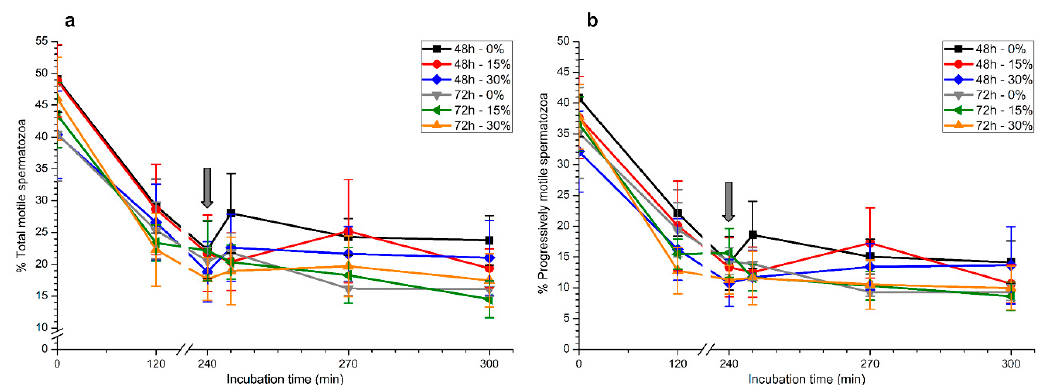
Figure 1. Percentages of total ( a ) and progressively motile spermatozoa ( b ) during in vitro capacitation and progesterone-induced acrosomal exocytosis (300 min) after previous storage of spermatozoa at 17 °C with different concentrations of seminal plasma (0%, 15%, and 30%) for 48 h or 72 h. Grey arrow indicates the time at which 10 μ g/mL progesterone was added to induce acrosomal exocytosis (i.e., 240 min). No significant differences ( p > 0.05) between treatments were observed. Data are shown as mean ± standard error of the mean (SEM) for seven independent experiments.